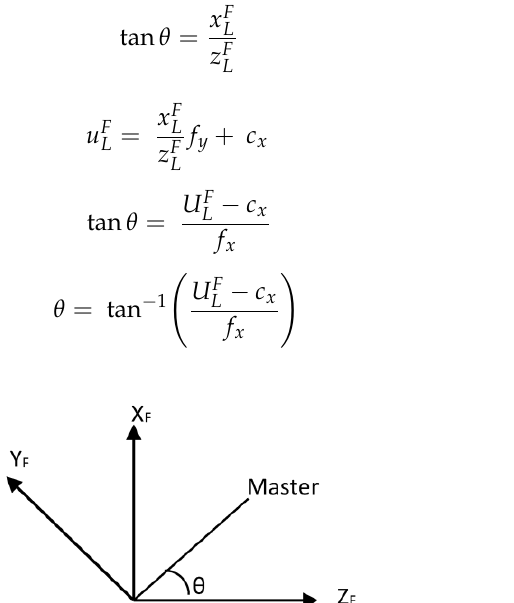
Figure 4. Calculation of the angle to the master robot.